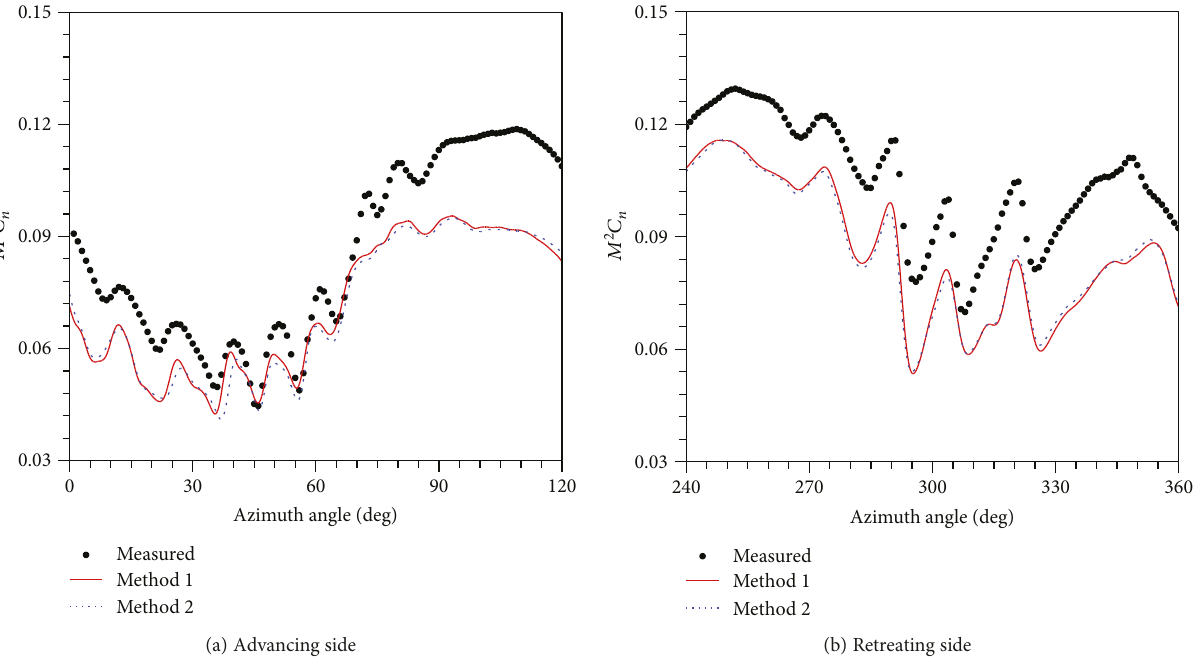
Figure 10: Comparison of enlarged view of section airloads M 2 C